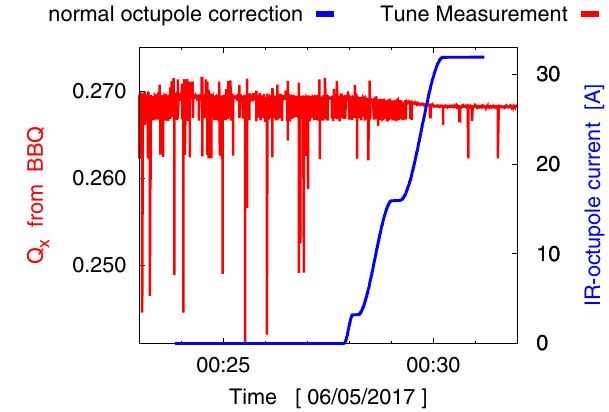
FIG. 8. Improvement in online tune measurement quality upon application of corrections for normal octupole errors in the ATLAS (IR1) and CMS (IR5) insertions.